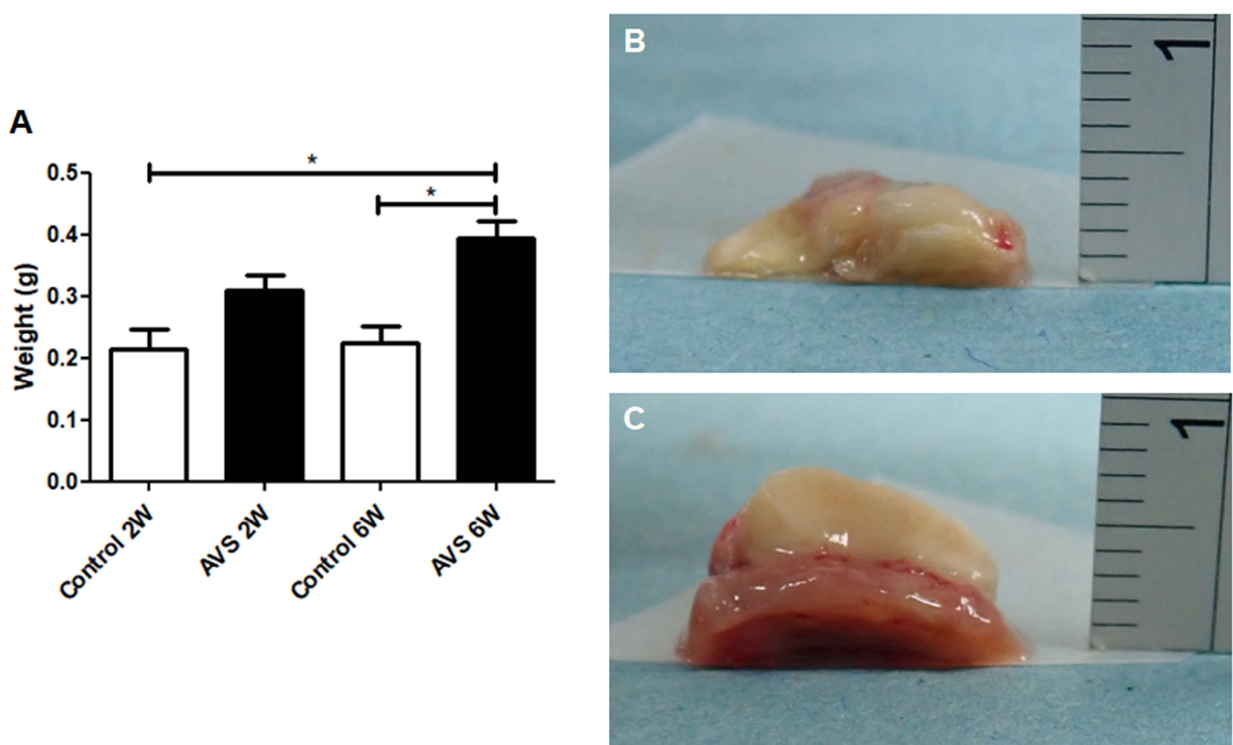
Figure 4. Weight gain after two and six weeks. The weight of vascularized and non-vascularized mSVF explants (without the chamber) was measured immediately after explantation and ( A ) show a significant increase in weight in the vascularized mSVF explants after six weeks as well as a significant weight difference between vascularized and non-vascularized mSVF explants after two and six weeks. Representative photographs of ( B ) non-vascularized mSVF explants after six weeks with macroscopic signs of necrosis and ( C ) vascularized mSVF explants after six weeks with viable tissue and only marginal necrosis on the top of the explants are shown. * p < 0.05.